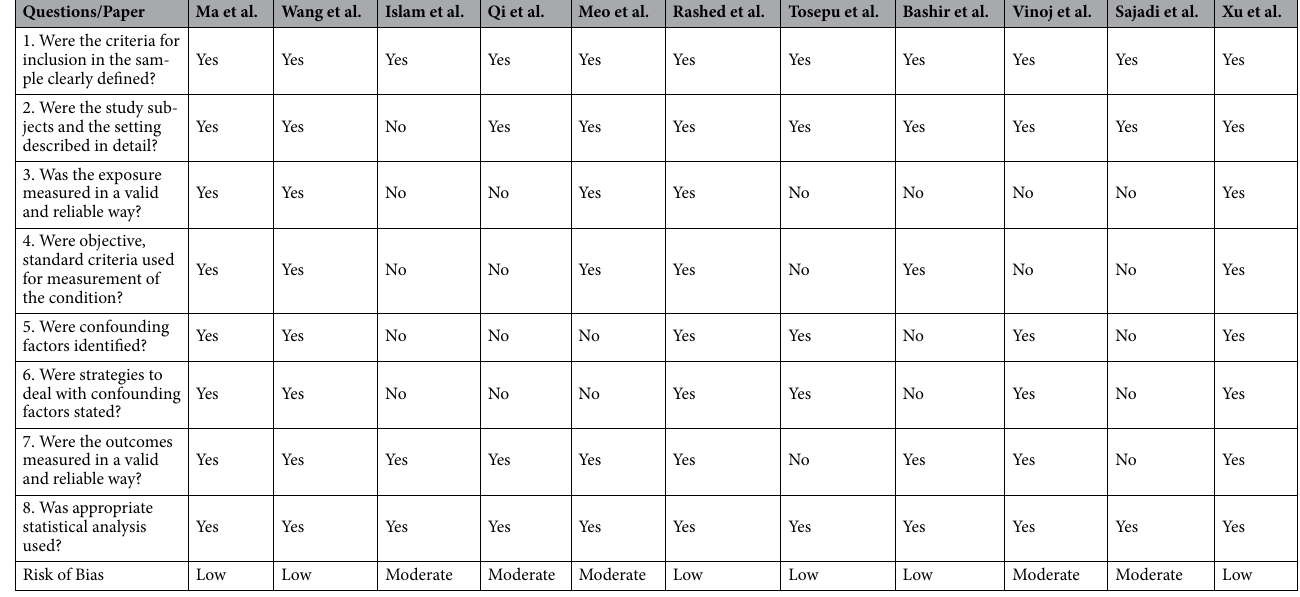
Table 2. Risk bias assessment of the literature included in this